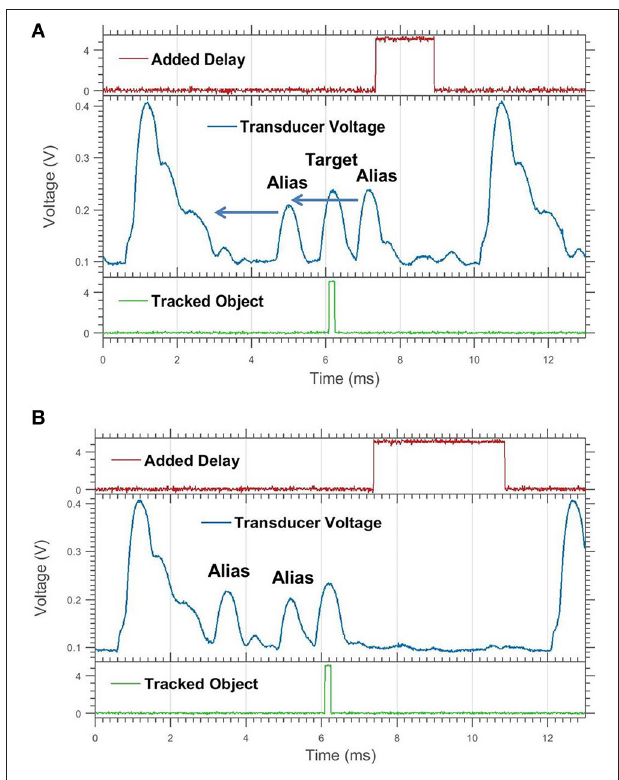
FIGURE 8 | A target being sandwiched by aliased echoes. (A) Here the alias in front of the stationary target approaches the target and triggers a delay jump. (B) This clears both aliases away from the target, drawing them both forward of the target.